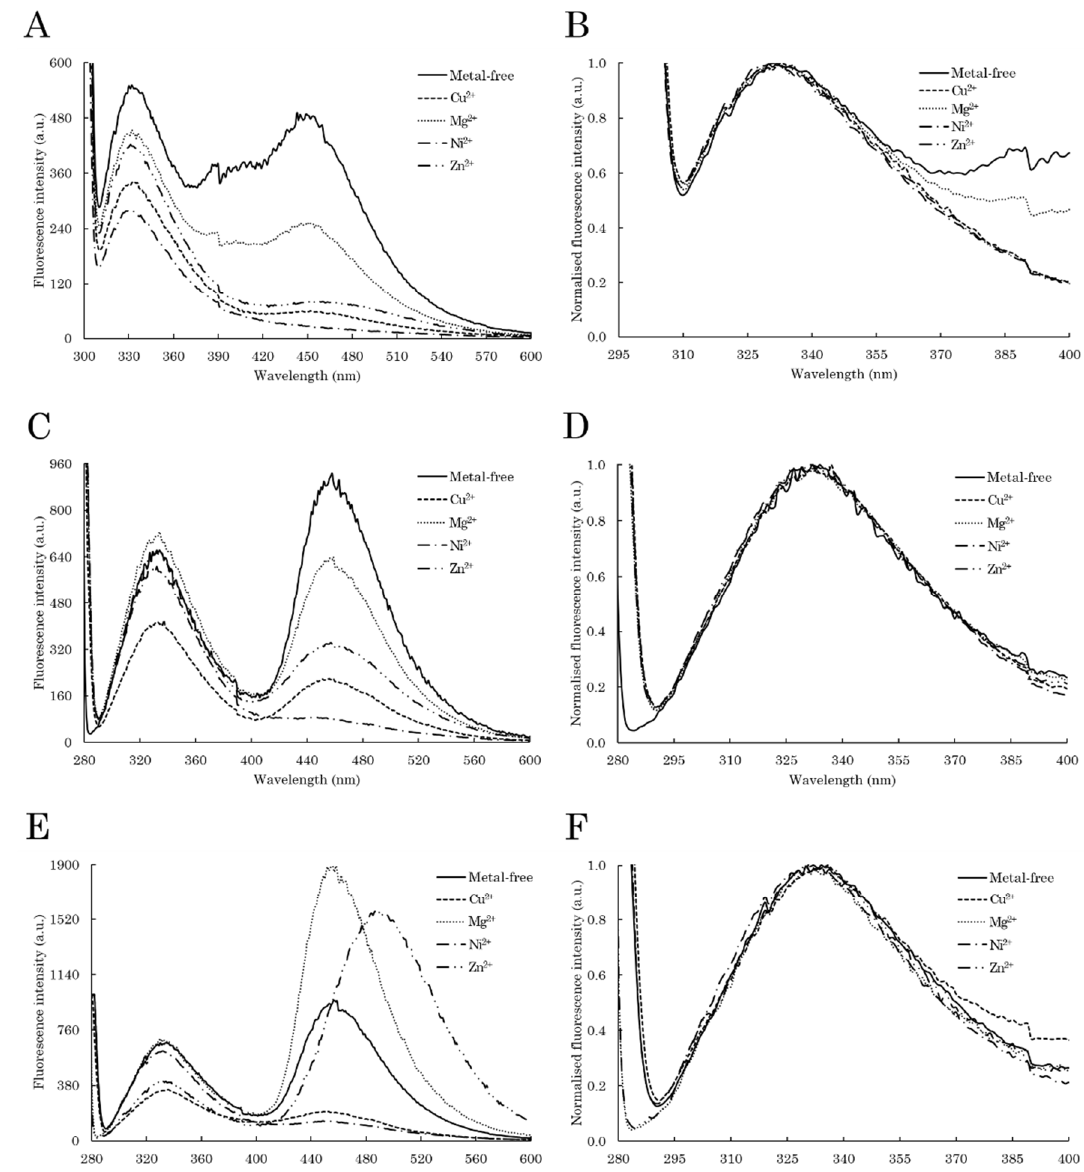
Figure 9. Intrinsic fluorescence spectra of C ‐ TERb ( A – D ) and C ‐ TERa ( E , F ) incubated in TBS at ~20 °C for 72 h (C C ‐ TER = 5 μ M) without metal (solid line) and in the presence of Cu 2+ (dashed line), Mg 2+ (dotted line), Ni 2+ (dashed ‐ dotted line), and Zn 2+ (dashed ‐ double ‐ dotted line) cations (C M2+ = 100 μ M). ( A ) ITF and ( B ) normalised first ITF band spectra ( λ ex = 295 nm, sw = 10 nm). ( C , E ) ITyrF and ( D , F ) normalised first ITyrF band spectra ( λ ex = 275 nm, sw = 10 nm).